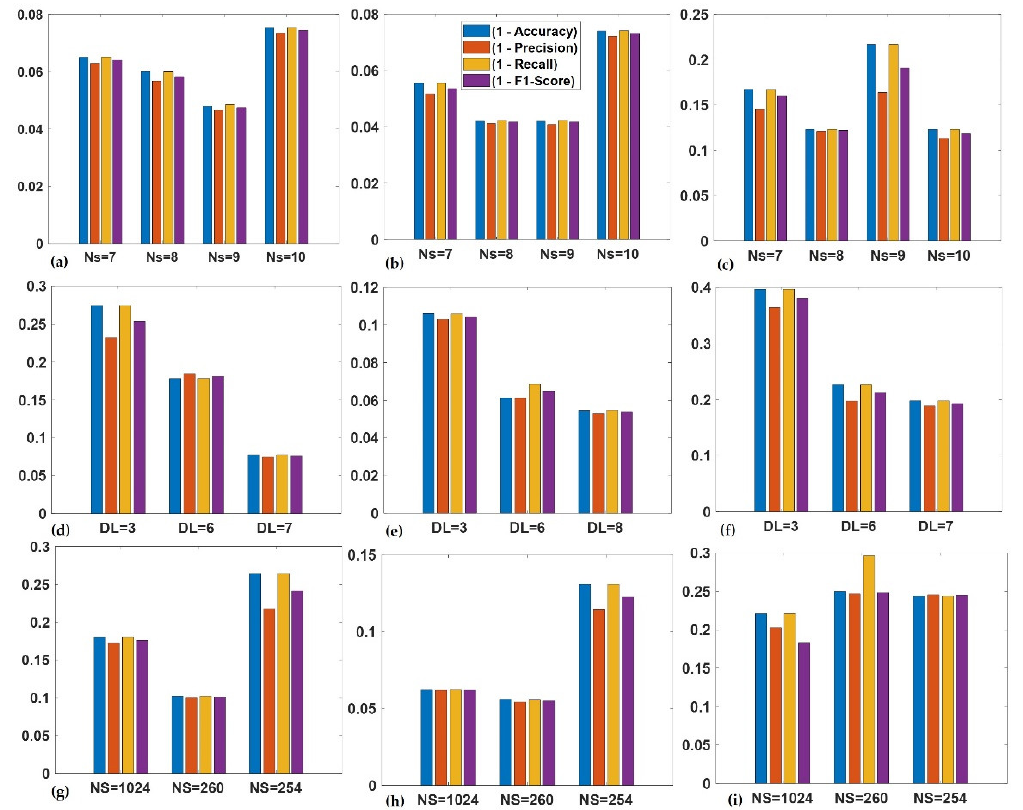
Figure 11. Optimization of model based on ( a ) CSC of shaft, ( b ) CSC of bearings, ( c ) CSC of gear, ( d ) SK of shaft, ( e ) SK of bearings, ( f ) SK of gear, ( g ) bicoherence of shaft, ( h ) bicoherence of bearing, and ( i ) bicoherence of gear.